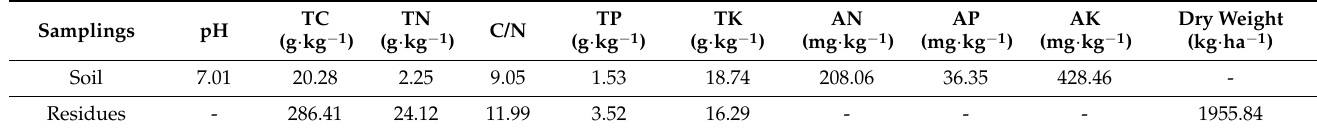
Table 1. The soil physicochemical